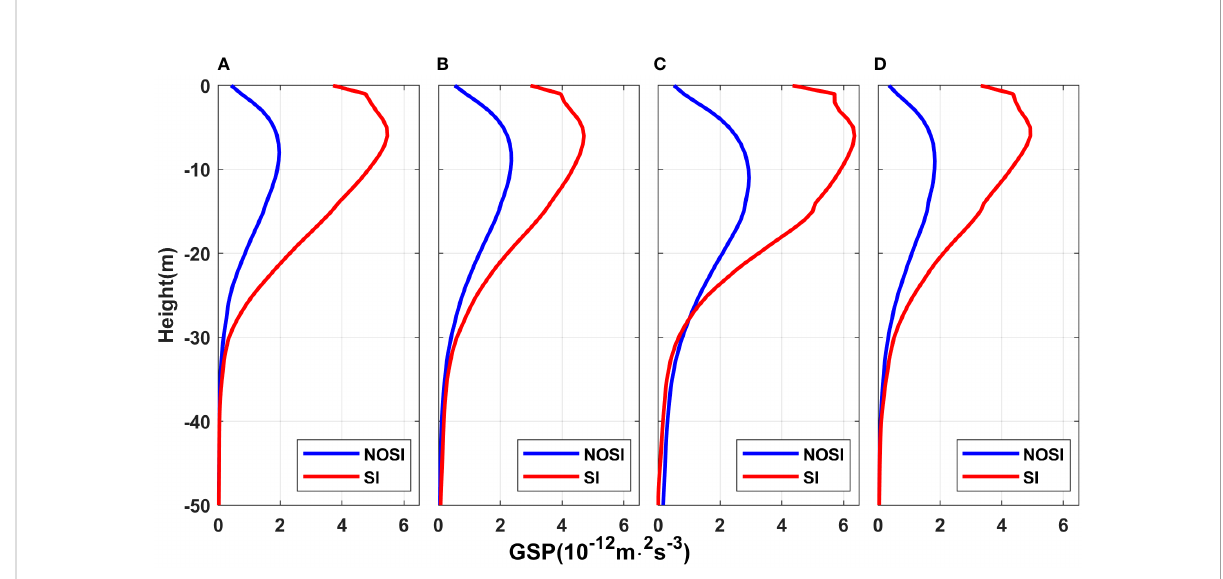
FIGURE 5 The domain-averaged vertical pro fi le of GSP in January (A) 2017, (B) 2018, (C) 2019, (D) 2020. GSP, geostrophic shear